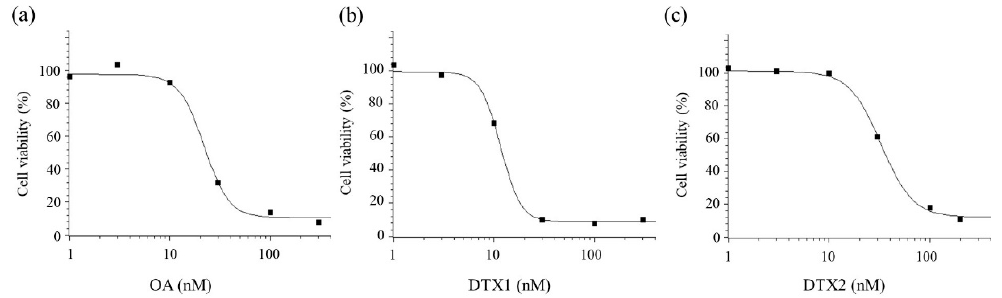
Figure 3. Effect of OA ( a ), DTX1 ( b ), and DTX2 ( c ) on the viability of neuro-2a cells. Each point represents the mean (n = 6) with an intra-plate SD of less than 11%.